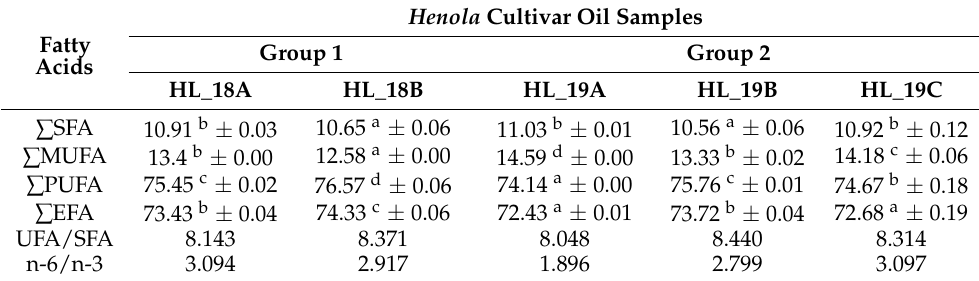
Table 2. Fatty acid composition expressed as a percentage of total fatty acid (%) of cold-pressed hemp seed oils of the Henola